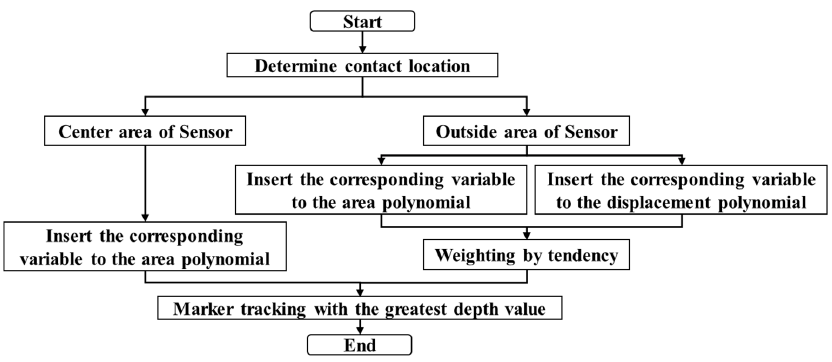
Figure 9. Marker position estimation diagram from polynomial fitting process.